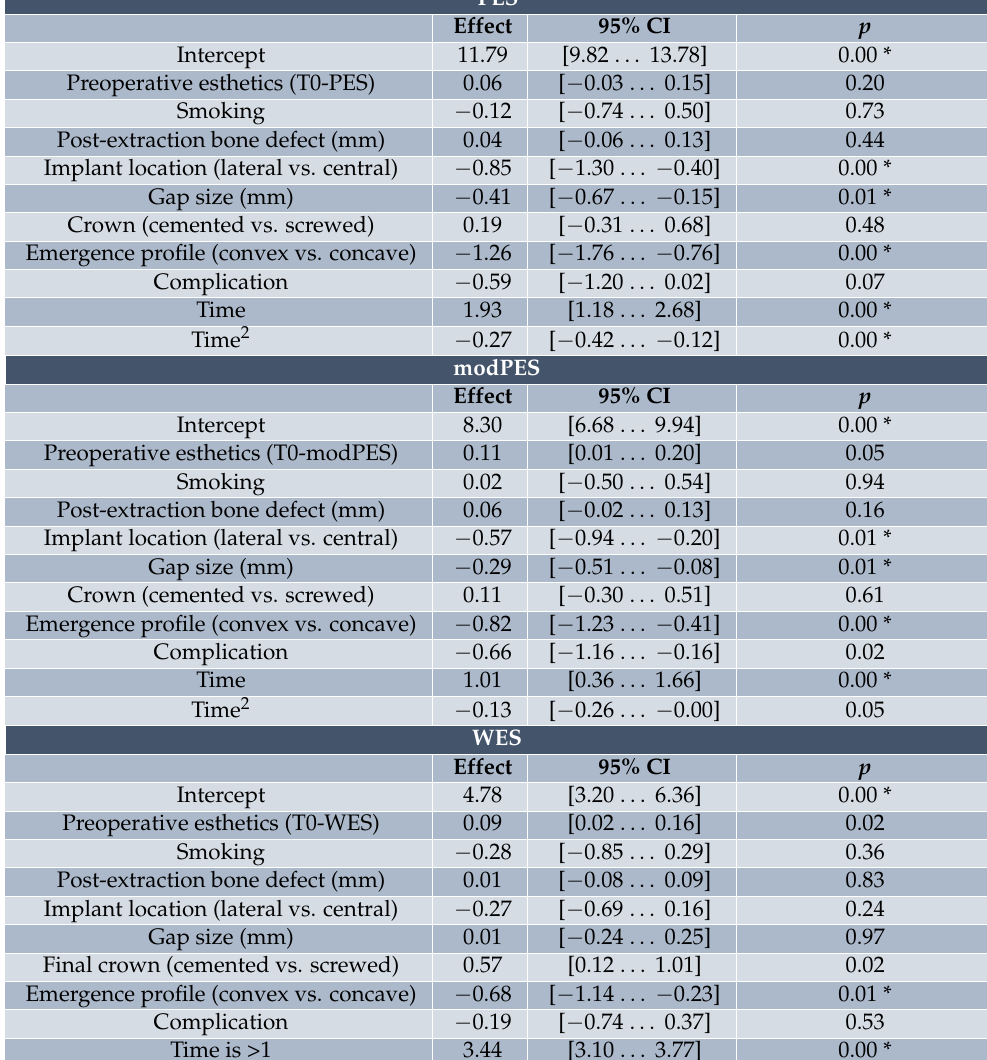
Table 4. Factors associated with the esthetic results after FIIPP (* means p ≤